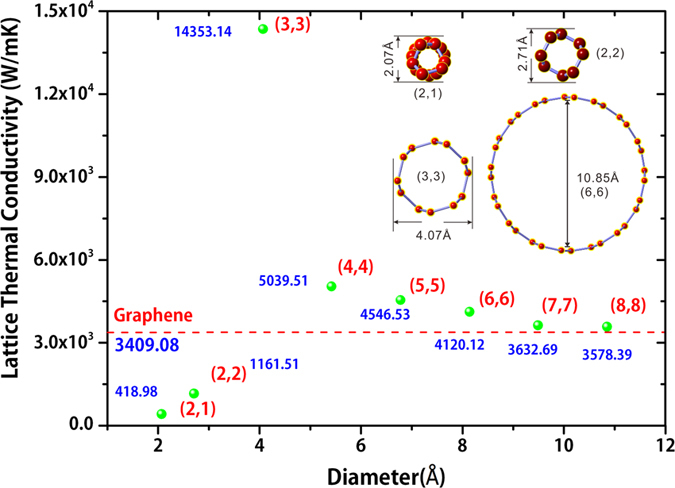
Lattice thermal conductivity of SWCNTs with different diameter.The dashed line represents the thermal conductivity of graphene. (Inset) cross-sectional view of atomic structure of typical SWCNTs.